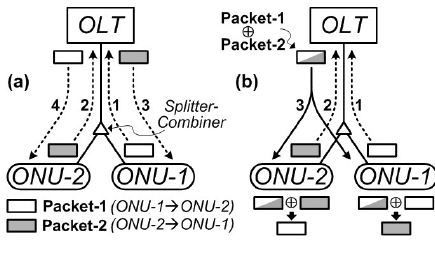
Figure 3. Network coding in a power-splitting PON.